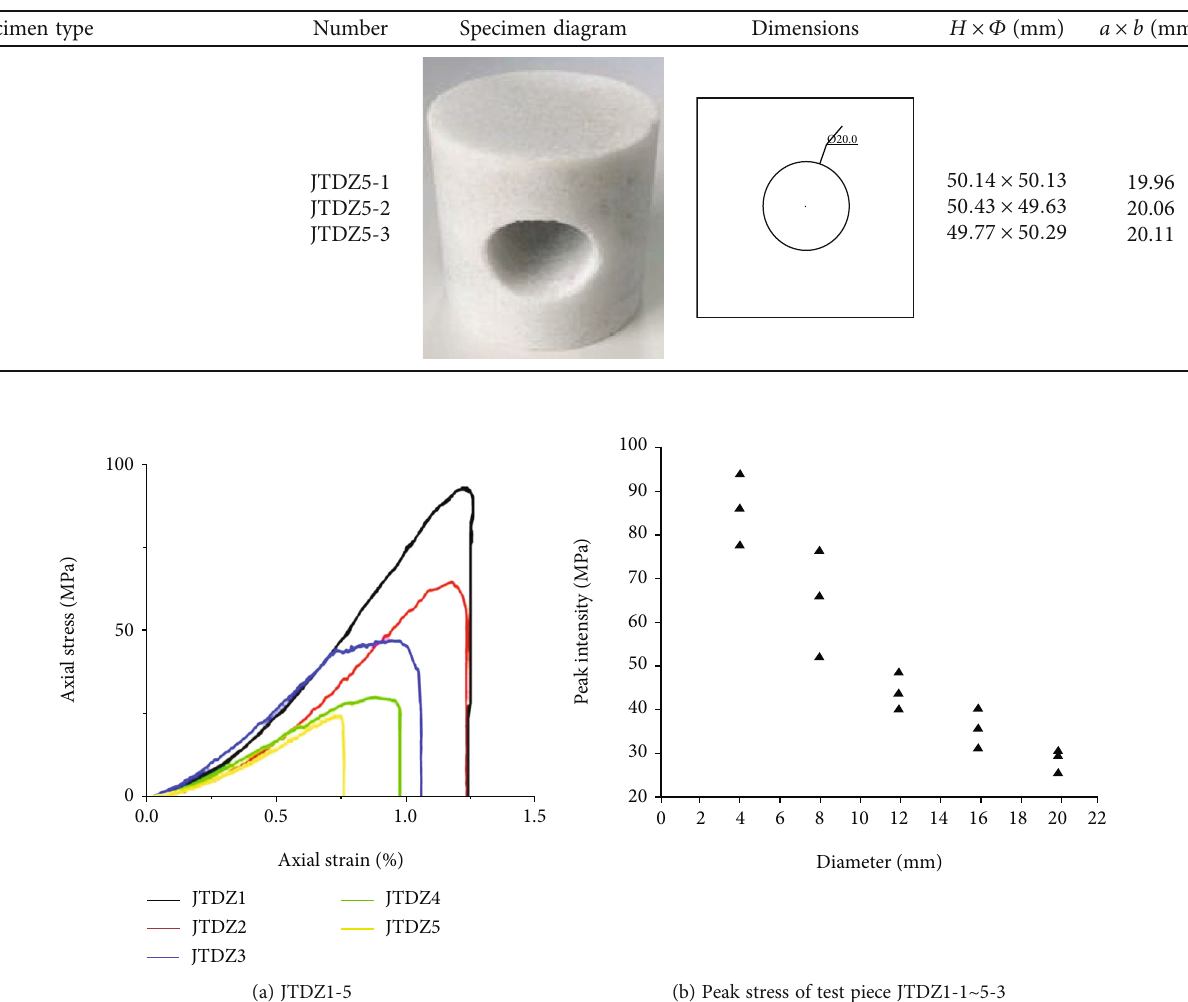
Figure 2: Axial stress-strain relationship curve and peak stress scatter plot of circular open marble specimens: (a) JTDZ1-5; (b) peak stress of test piece JTDZ1-1 ~